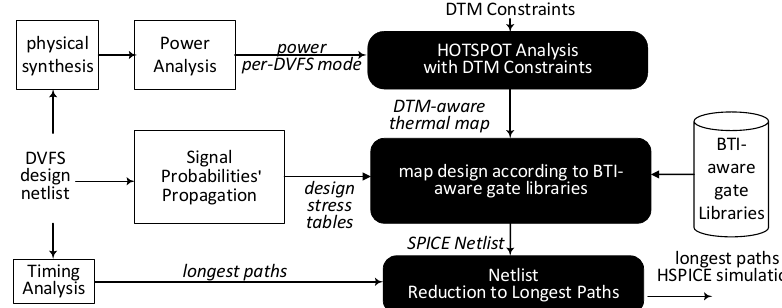
Figure 8. Proposed framework for BTI degradation analysis of DVFS